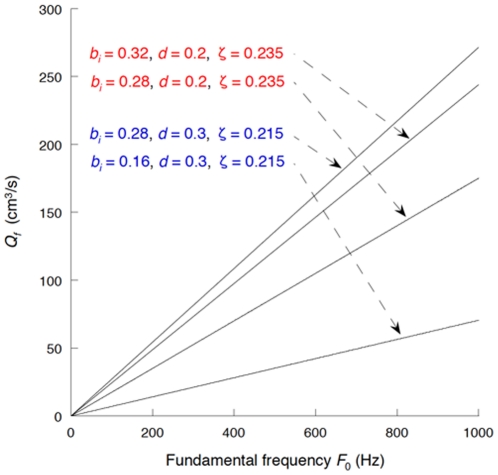
The effect of vocal fundamental frequency F
0 on Qf.